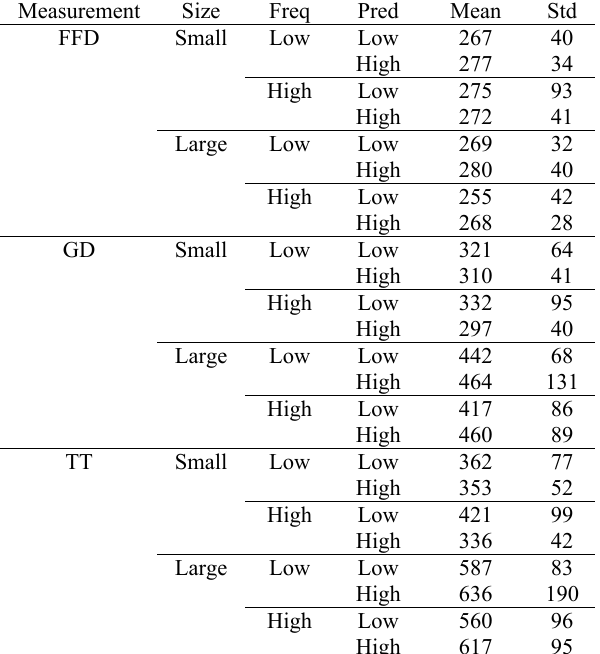
Table 4 Summary of mean and standard deviation (in ms) based on visual scene analysis